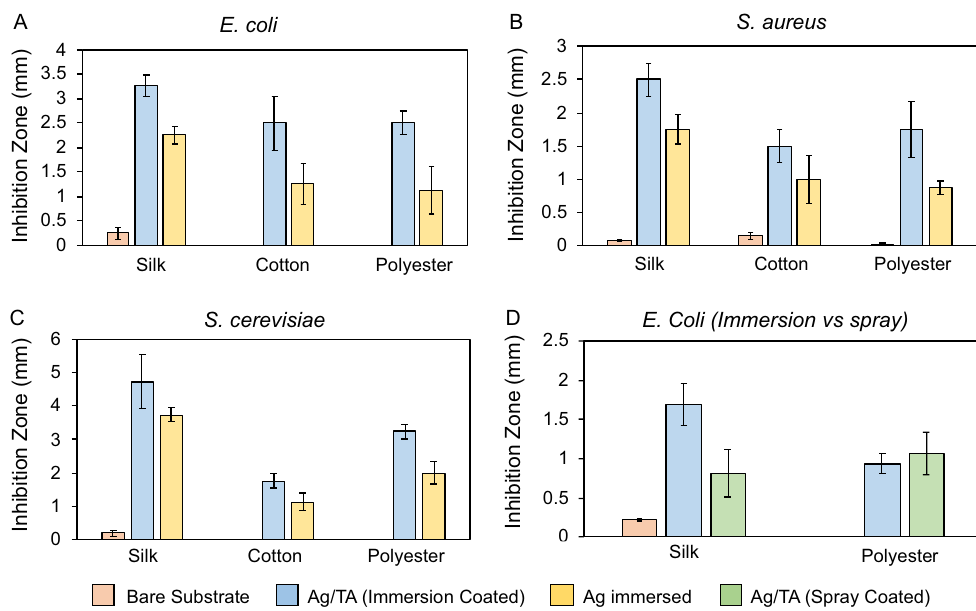
Figure 3. Antibacterial and antifungal properties of Ag/TA coatings on different textiles. Inhibition zones of uncoated, Ag/TA-coated, and AgNO 3 -immersed silk, cotton, and polyester after incubation with E. coli ( A ), S. aureus ( B ), and S. cerevisiae ( C ). ( D ) Comparison of E. coli inhibition between Ag/TA coatings applied with immersion or spraying on silk and